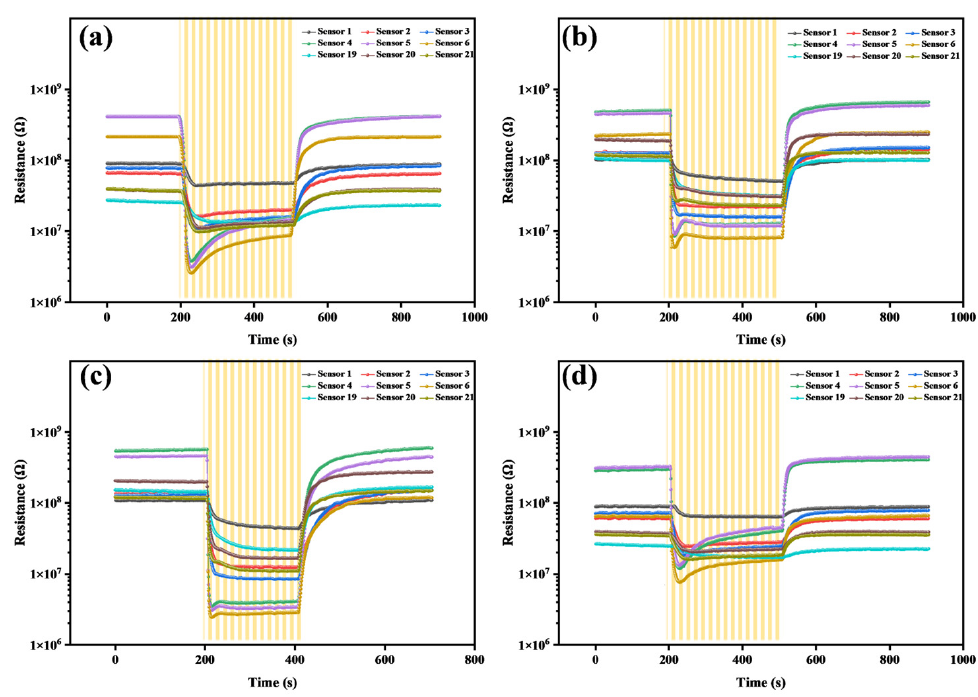
Figure 9. Response and recovery time of nine gas sensors exposed to 100 ppm of four gases at 250 °C, ( a ) benzene, ( b ) toluene, ( c ) xylene, and ( d ) formaldehyde.